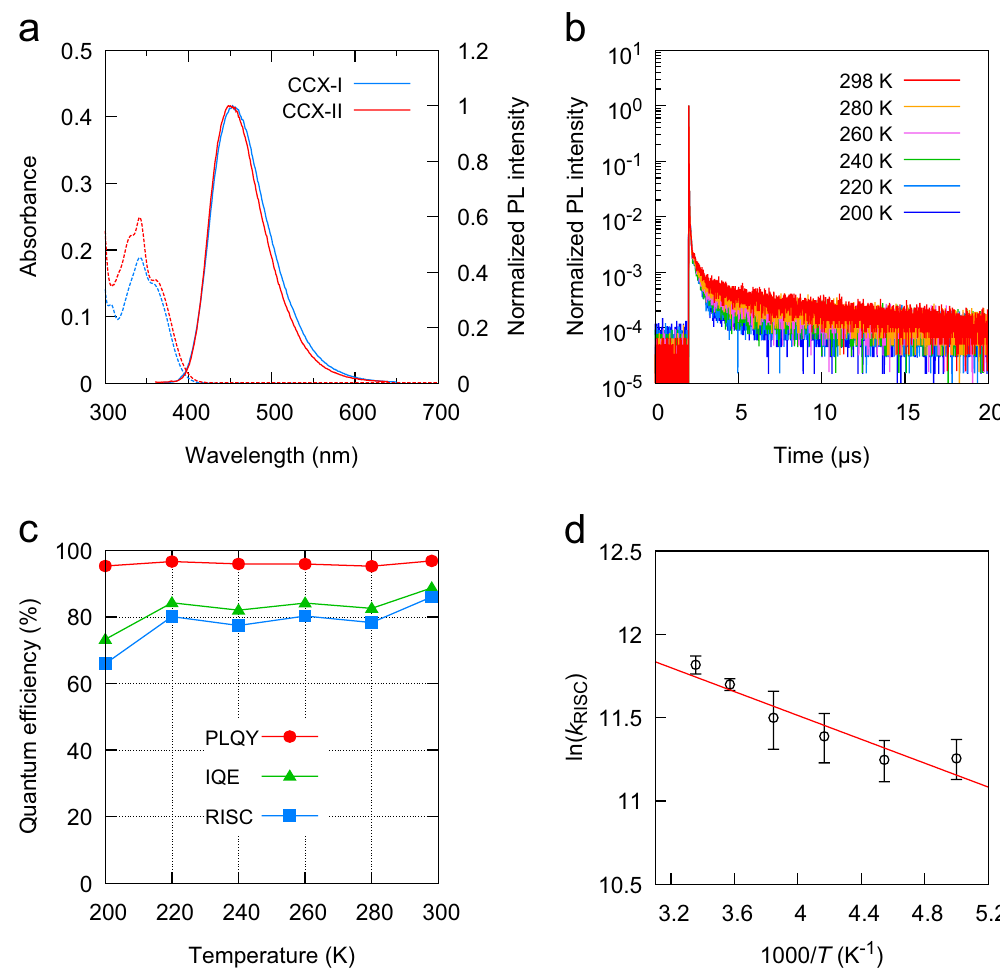
Figure 4. Photophysical properties. ( a ) PL and UV-vis spectra of CCX-I and CCX-II in toluene solution (1.0 × 10 − 5 M). ( b ) Transient PL decay curves at 200–298 K for a 6 wt% CCX-II:PPF film. ( c ) Temperature dependences of PLQY, RISC efficiency, and IQE for a 6 wt% CCX-II:PPF system. ( d ) Arrhenius plot of the rate constant of RISC for 6 wt% CCX-II:PPF system. A Δ E ST of 31 meV was obtained by least-squares fitting (red solid